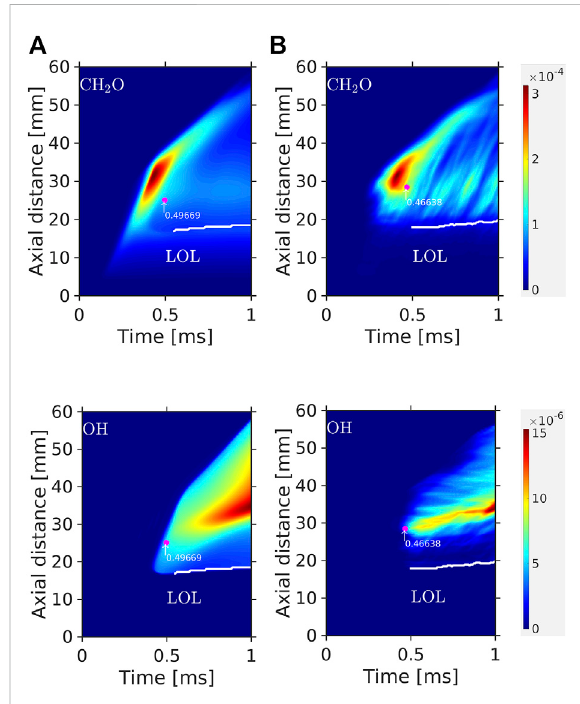
FIGURE 6 I xt -plots for Spray C in the RANS (A) and LES (B) frameworks. The purple dot represents the